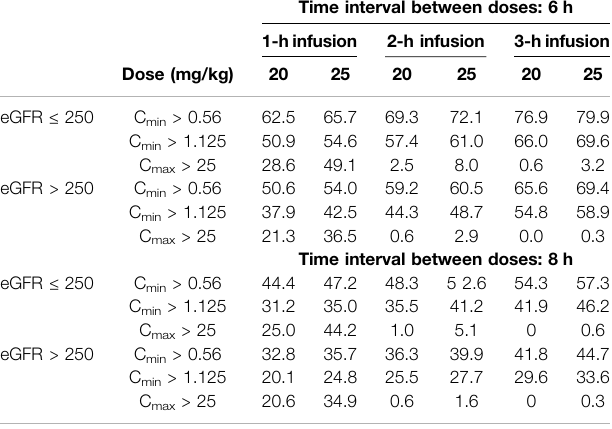
TABLE 7 | Results from simulated regimens consisting in ACV doses of 20 and 25 mg/kg infused in 1 h (standard regimen) or in prolonged infusions (2 and 3 h). The percentages of patients who achieved C min values > 0.56 and > 1.156 mg/L or C > 25 mg/L are showed according to an eGFR max values threshold of 250 ml/min/m 2 . Each regimen consists of 1,000 simulated